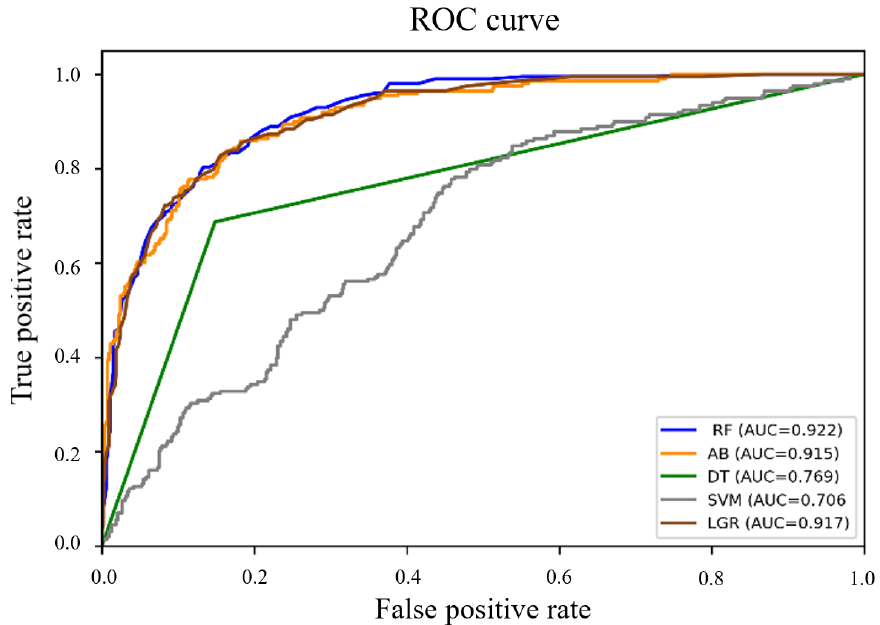
Figure 3. ROC curve comparing AUCs of different machine learning models and logistic regression model. ROC: receiver operating characteristic; RF: random forest; AB: adaptive boosting; DT: decision tree; SVM: support vector machine; LGR: logistic regression. Table 4. AUC, sensitivity, specificity, PPV, and NPV of each machine learning model. Model AUC (95% CI)